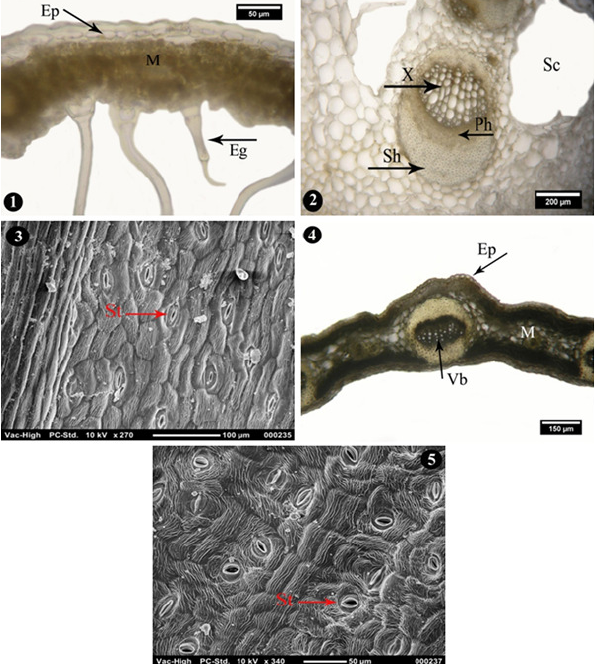
Fig. 3. Leaf anatomical structures of Inula species. 1-2. Cross- section of leaf of I. helenium subsp. orgyalis , 3. The lower surface of leaf of I. helenium subsp. orgyalis in SEM, 4. Cross- section of leaf of I. ensifolia , 5. The lower surface of leaf of I. ensifolia in SEM. Ep: epidermis, Eg: eglandular trichome, M: mesophyll,